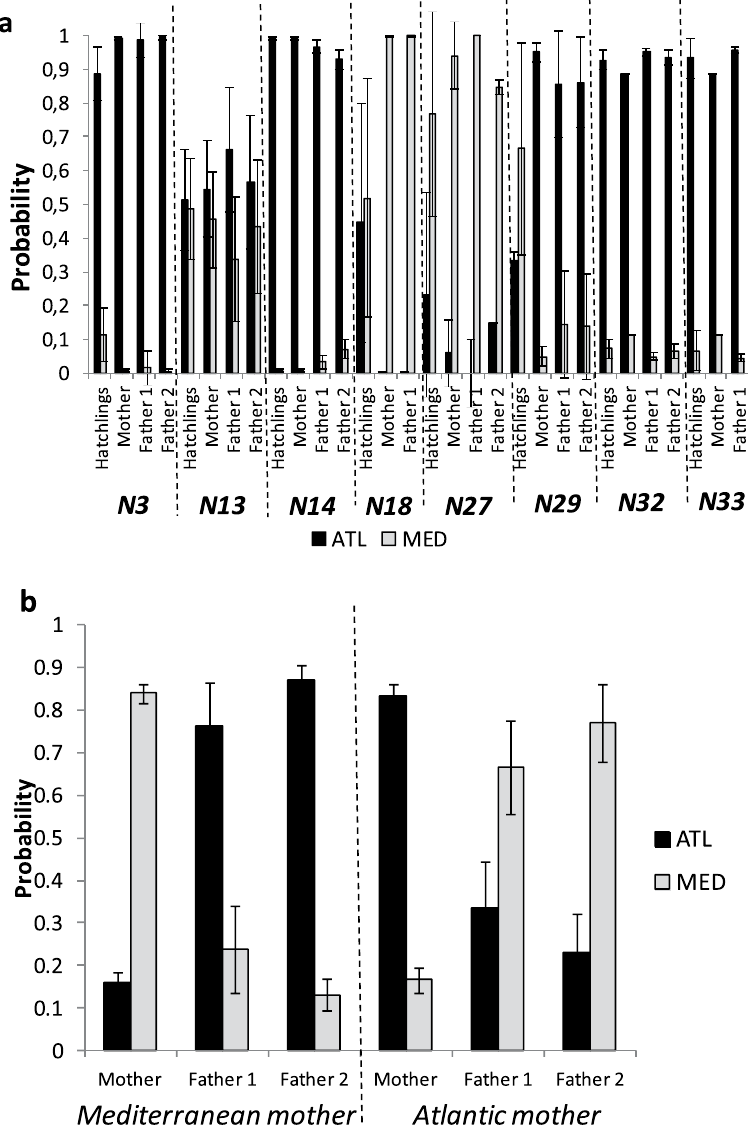
Figure 2. Individual Assignments of the sporadic nests with multiple samples assayed. ( a ) mean individual assignments of the sampled hatchlings and the inferred possible mothers and fathers of each one of the nests with more than two hatchling samples ( b ) mean individual assignments from Puzol nest ( N13 ) for the two different possible fathers after assigning the putative the mother (Mediterranean or Atlantic). The Y axis represents the probability of belonging to either the Mediterranean (MED: grey) or the Atlantic (ATL: black) groups created by STRUCTURE 46 . Standard deviations are indicated by error bars. Nests coded as in Table